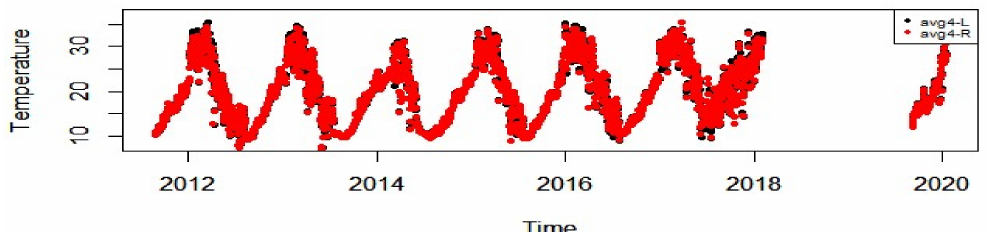
Figure 9. Avg4-R against avg4-L (Temperature in ◦ C).